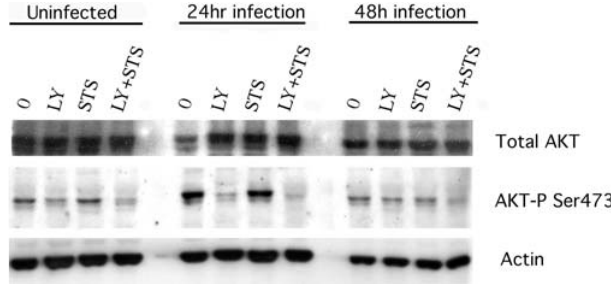
Figure 3. AKT Phosphorylation in Cells during Apoptosis of C. trachomatis -Infected Cells Cells were infected with C. trachomatis at an MOI of 1.0 for 24 or 48 h, or mock-infected, and then incubated with 50 l M LY294002 (LY) or control buffer for 6 h before treating with control buffer or 2 l M STS overnight. Cells were then collected for Western immunoblotting and analyzed for phosphorylation of AKT on residue Ser 473 , as described in Materials and Methods. STS treatment by itself did not affect AKT Ser 473 phosphor- ylation in infected cells, but LY294002 caused AKT Ser 473 to become partially dephosphorylated. This residue became dephosphorylated almost completely when LY294002 was combined with STS in infected cells. One experiment of two representative experiments performed on separate days is shown. DOI: 10.1371/journal.ppat.0020045.g003